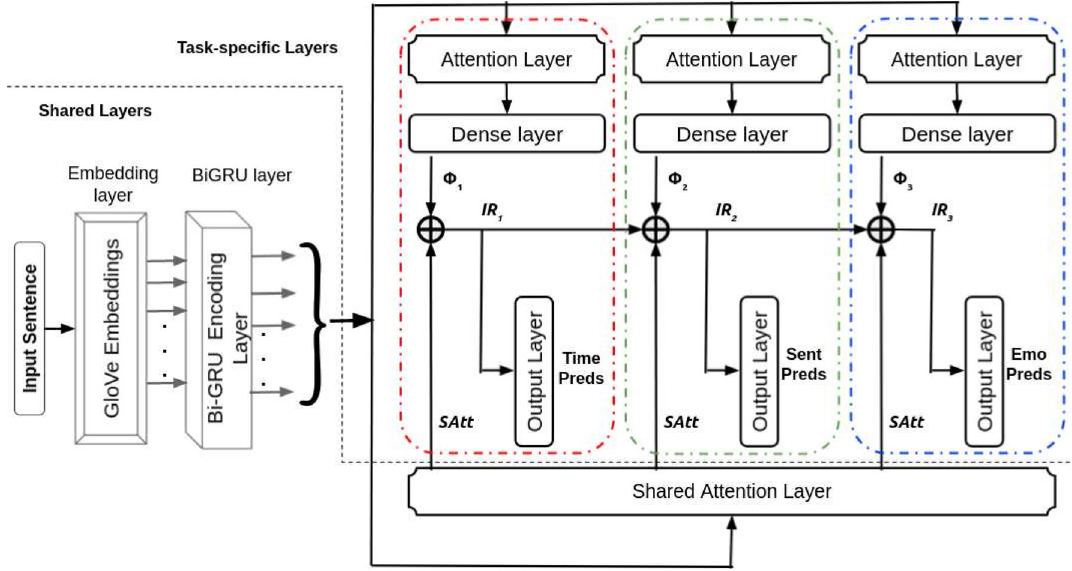
Figure 1. Architecture of shared-private attentive network with multi-layer cascades. Color-coded red, green, and blue dashed lines depict the three sub-networks participating in the layer cascading. The grey dashed line indicates the separation of the shared and task-specific